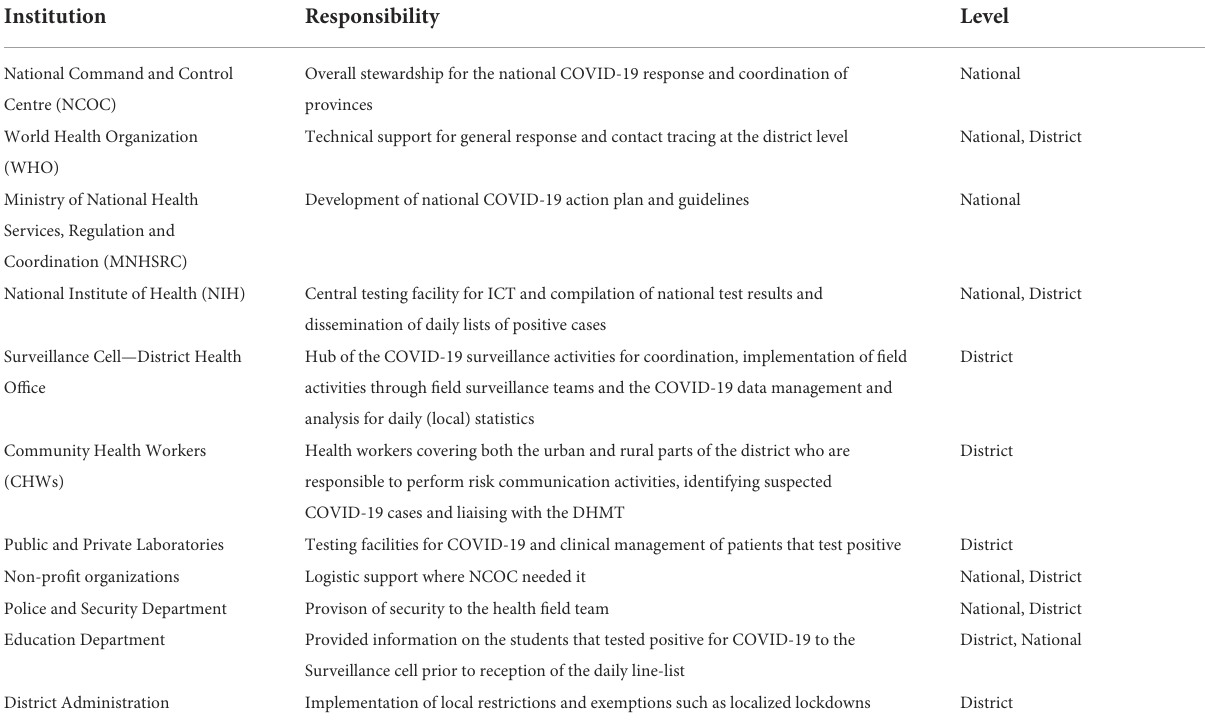
TABLE 2 Responsibilities of the stakeholders involved in the contact tracing